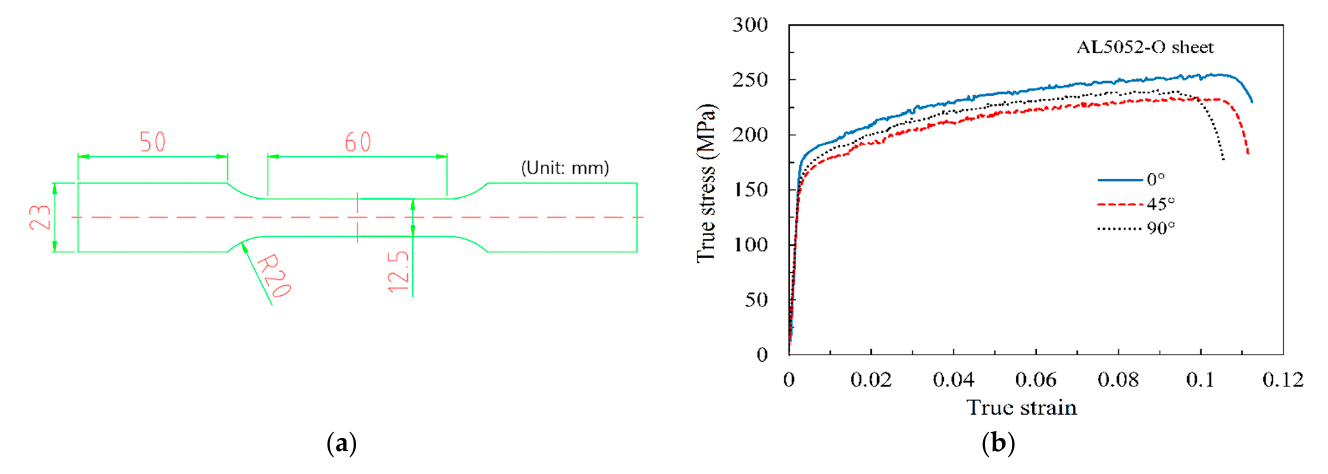
Figure 1. ( a ) Dimensions of tensile test specimen. ( b ) Stress–strain curves of the AL5052-O sheet for three different orientations. Table 1. Mechanical properties of Al5052-O.